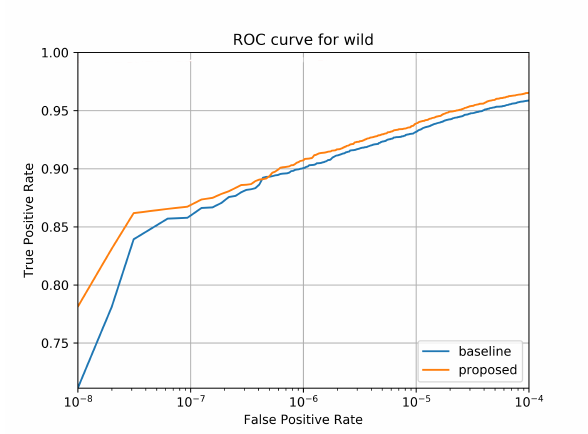
Figure 6. Face recognition in wild conditions